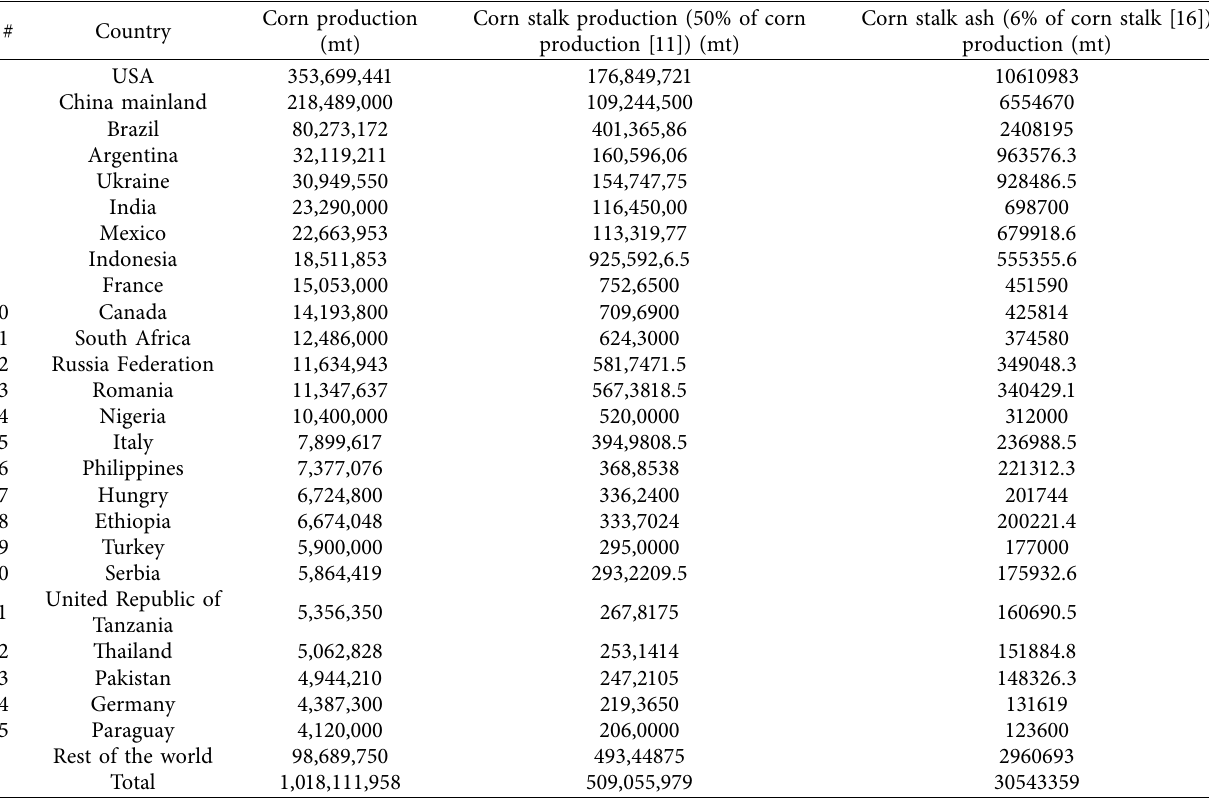
Table 1: Corn, corn stalk, and potential corn stalk ash production for top 25 countries of the world.